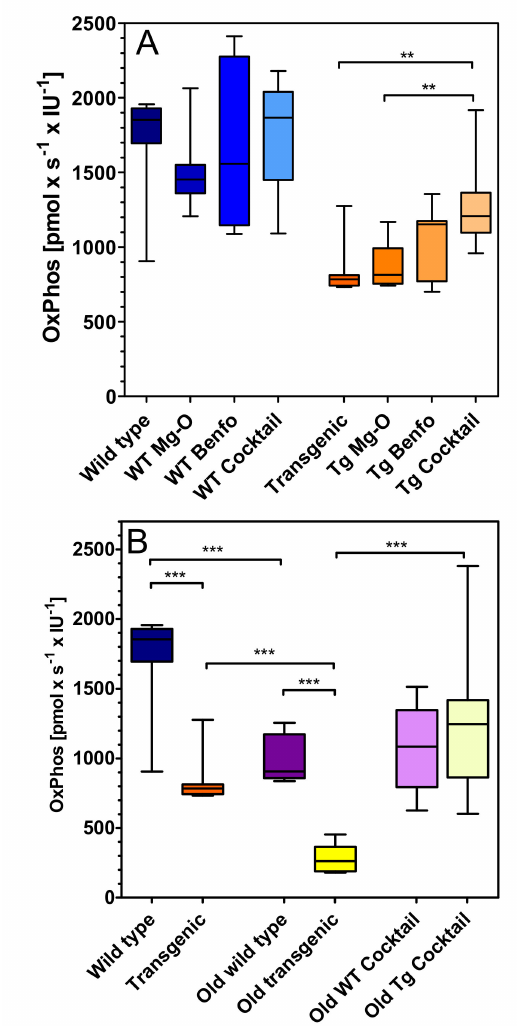
Figure 4. Oxygen flux related to oxidative phosphorylation (OxPhos) in ( A ) young wild-type and transgenic rats and ( B ) young and old rats treated with cocktail. Substrates, uncoupler and inhibitors were used to measure oxidative phosphorylation-related oxygen consumption as described in methods. Raw data were normalised to mitochondrial citrate synthase activity. A: (left) Treatment in wild type (WT), (right) treatment in transgenic (Tg) animals. Statistical analysis: Data are box plots (lower and upper quartile) with whiskers ( n = 7–10) and were analysed by one-way ANOVA followed by Bonferroni’s multiple comparison test: (a) F3,33 = 0.84, p = 0.48; (b) F3,33 = 7.06, p = 0.001. ** p < 0.01 B: Genotype, treatment and age related effects. Statistical analysis: Data are box plots (lower and upper quartile) with whiskers ( n = 8–10) and were analysed by unpaired t -test. *** p <